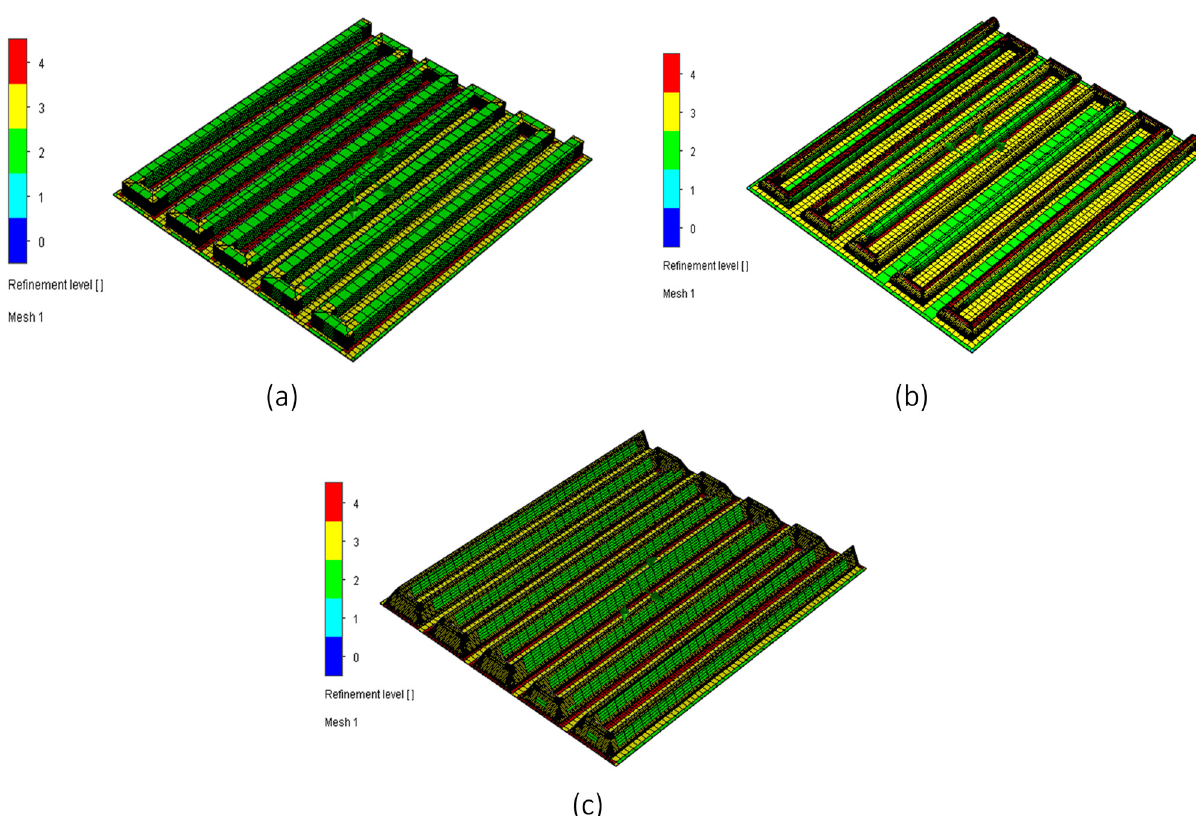
Figure 5: Results of mesh: ( a ) square box, ( b ) pipe box, and ( c ) triangle box.